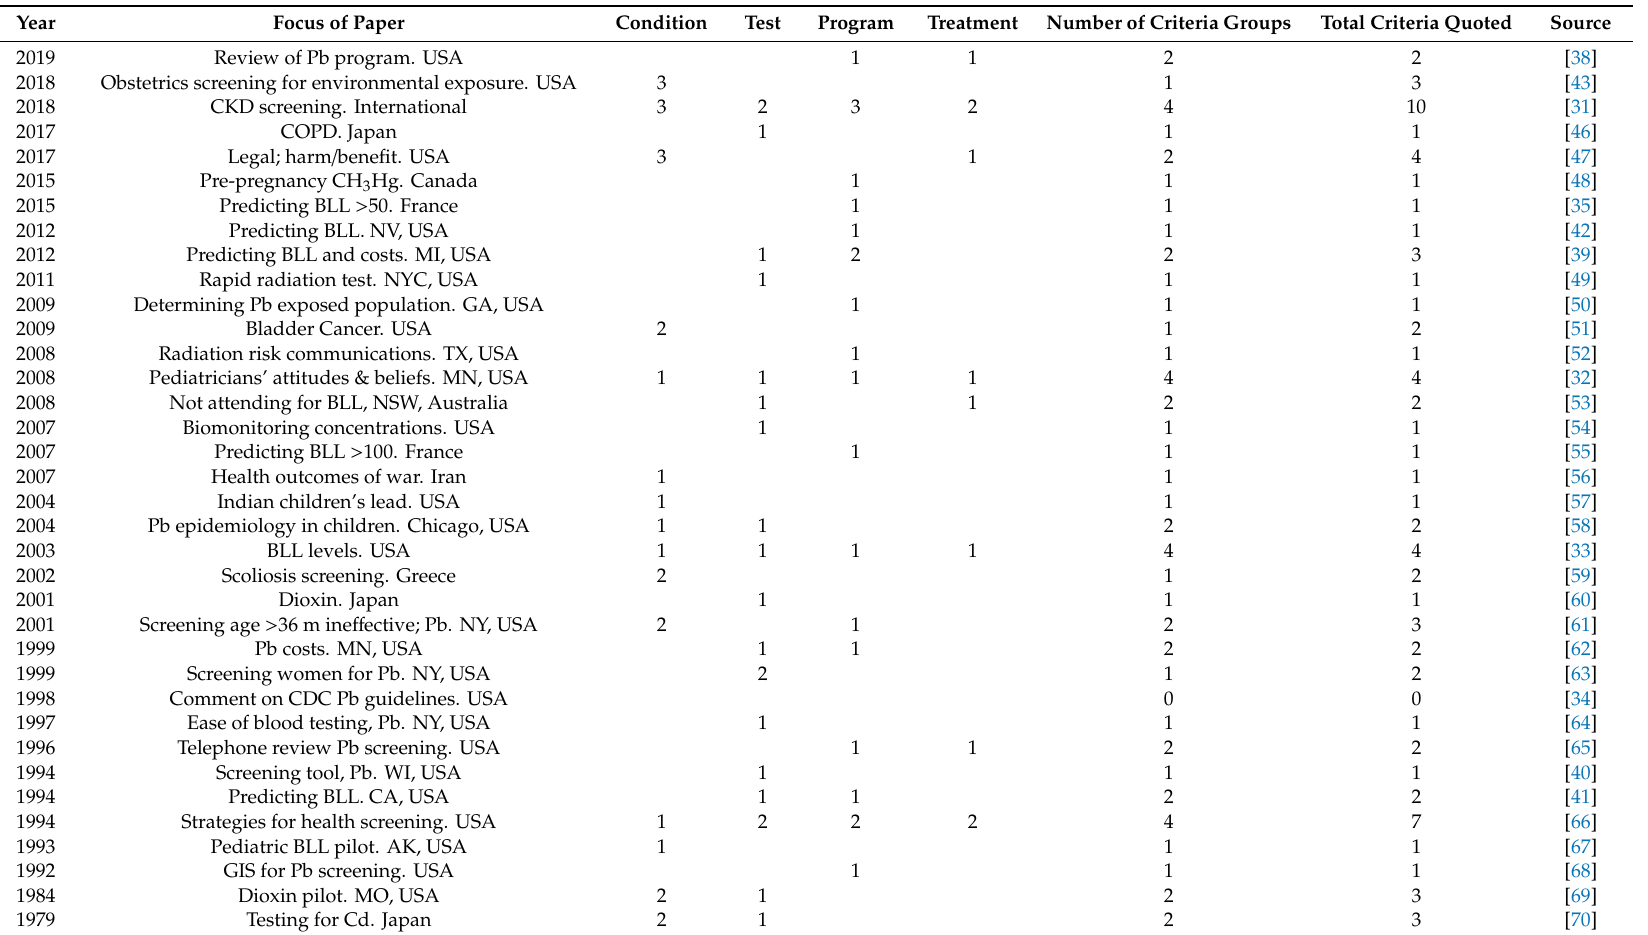
Table 2. Coverage in the literature review papers, within four recognized screening groups, of the 10 Wilson and Jungner screening criteria [17], showing the number of criteria covered and the group into which they